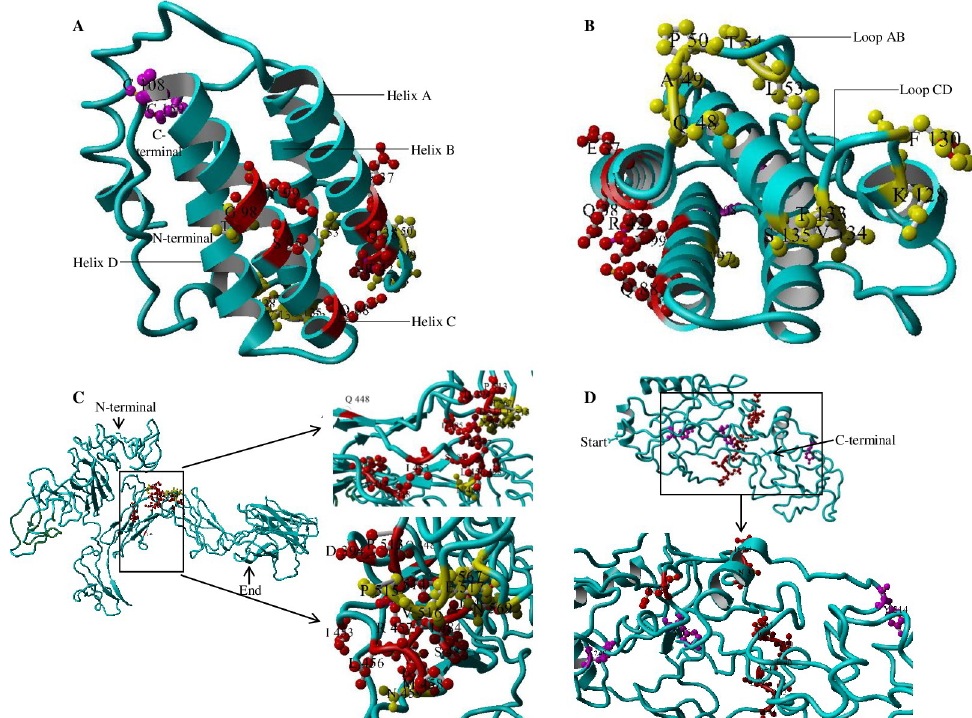
Fig 1. Tertiary structure of A,B leptin (Lepa) and C,D leptin receptor of C . punctata . A, B Using ball-and-stick model, residues of leptin involved in binding and signalling are highlighted in red and yellow colours, respectively. The cysteine residues are shown in purple. C In extracellular domain of leptin receptor, residues predicted essential for binding to the ligand and receptor activation/signal transduction are shown in red and yellow, respectively. D Represents intracellular domain of leptin receptor in which residues implicated in JAK2 activation are highlighted by red ball-and-sticks while tyrosine essential for receptor signalling by purple colour. The residues were labelled using YASARA software (version